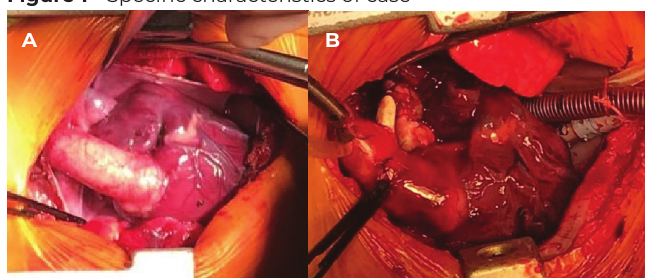
Figure 1 - Specific characteristics of case A